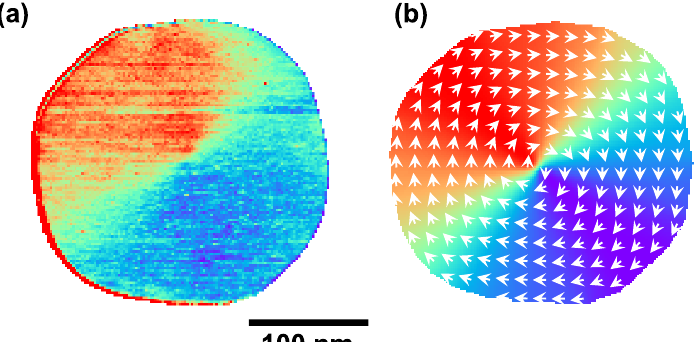
Figure 3. ( a ) Spin-polarized dI / dU map of an Fe island on W(110). I t = 1 nA, U 0 = − 400 mV, U mod = 50 mV; ( b ) Micromagnetic simulation of an island of the same shape as in the experiment.